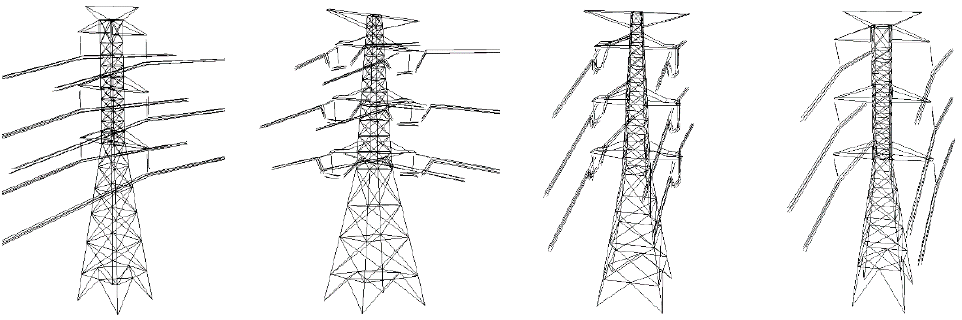
Figure A2. Detailed reconstruction models of power pylons and lines of test site.